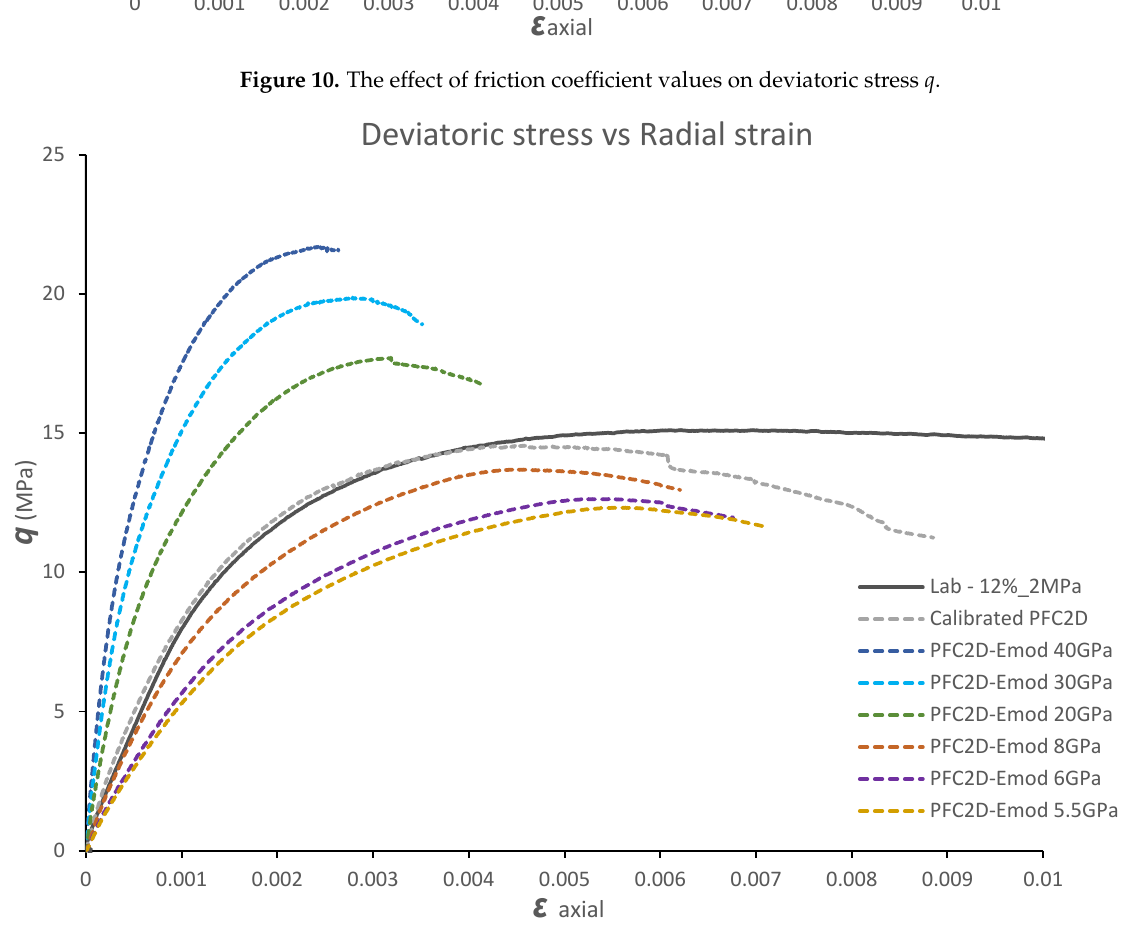
Figure 11. The effect of effective modulus values on deviatoric stress q.